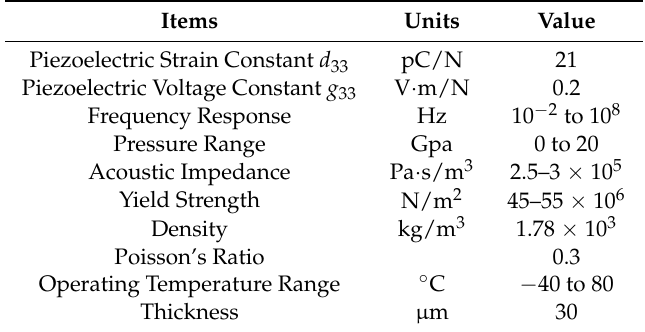
Table 1. Basic parameters of polyvinylidene fluoride (PVDF) material.